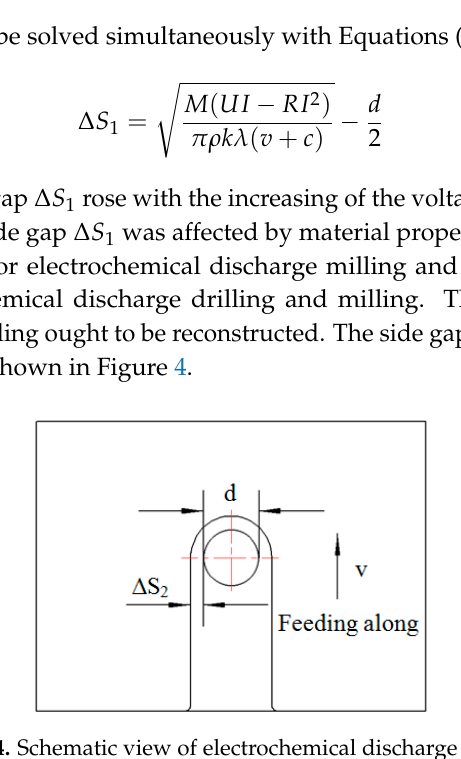
Figure 4. Schematic view of electrochemical discharge milling.